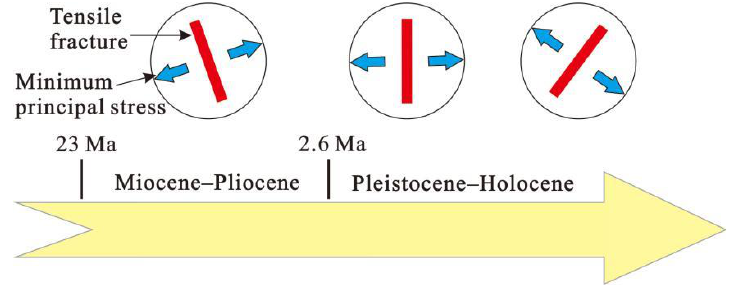
Figure 16. Evolution of bedrock fractures in the Kenya Rift Valley.